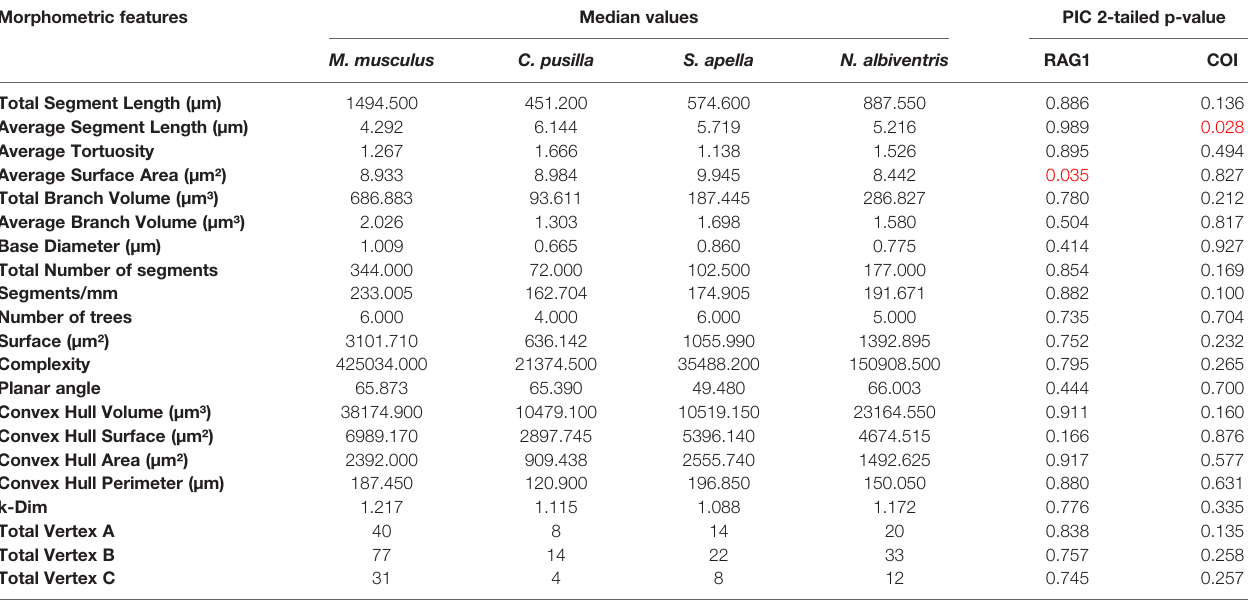
Red values indicate that the variable was statistically signi fi cant in PIC